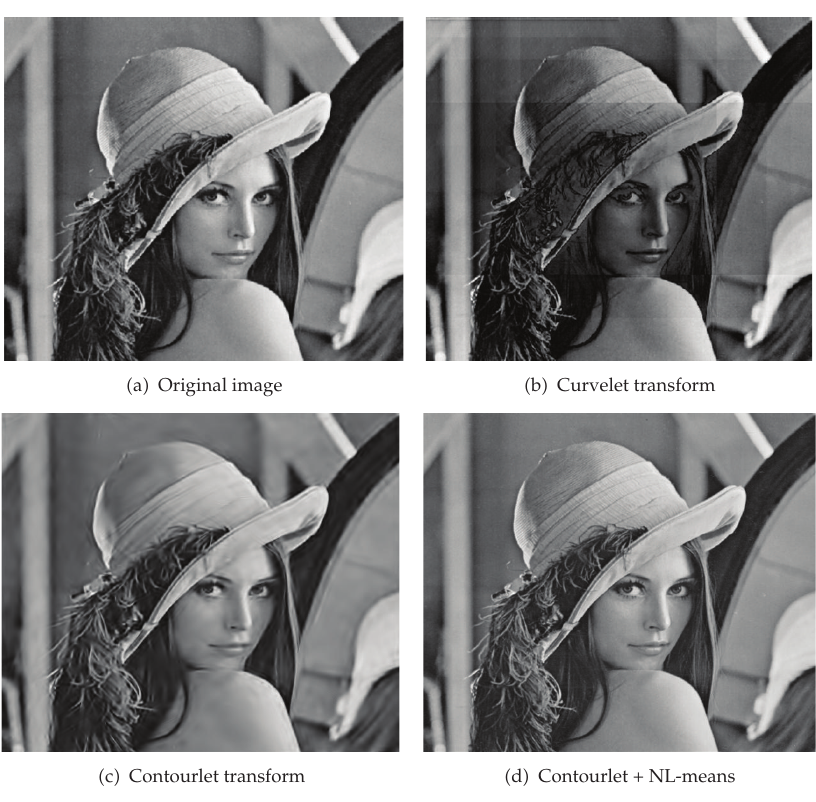
Figure 9: Process results for image